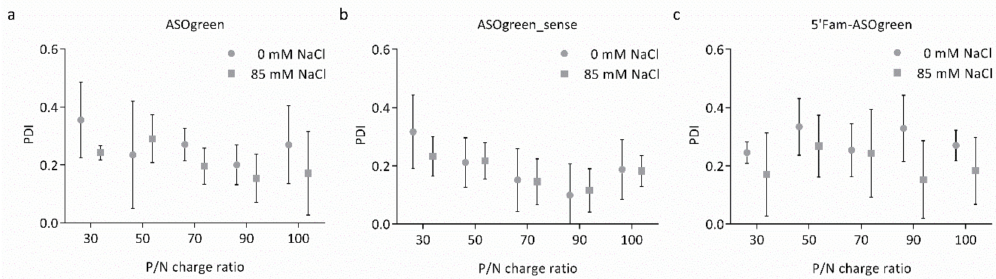
Figure 2. The polydispersity index (PDI) of CS–ASO nanocomplexes at varying P / N charge ratios. The PDI of CS–ASO nanocomplexes with ( a ) ASOgreen, ( b ) ASOgreen_sense and ( c ) 5 (cid:48) Fam-ASOgreen varied between 0.1 and 0.4. On average, nanocomplexes prepared in the presence of 85 mM NaCl had a lower PDI than nanocomplexes prepared without NaCl. The lowest PDI was observed in nanocomplexes at a P / N charge ratio of 90 ( n =